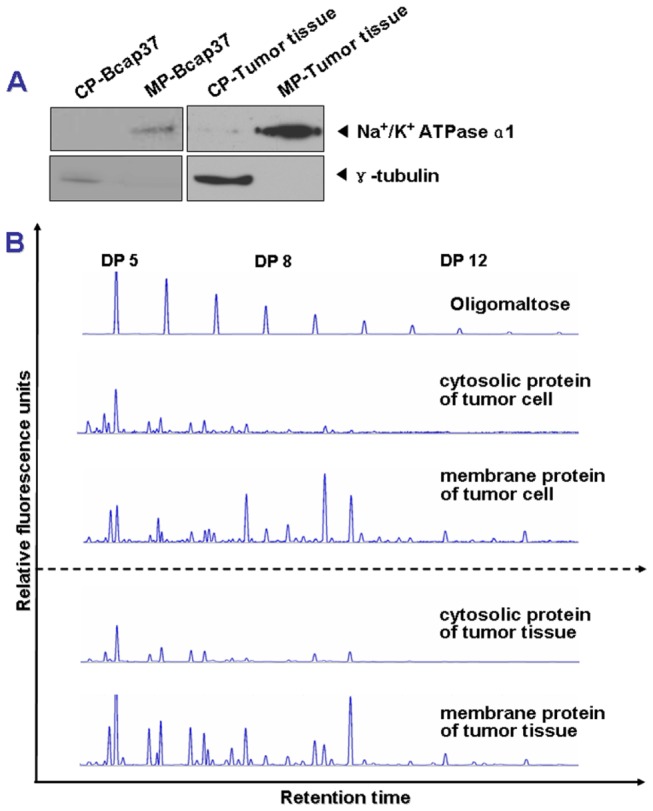
Establishment of the DSA-FACE method for analyzing N-glycan profiling in breast cancer.(A) Equal amounts (20 μg and 100 μg for cell line and tissue specimens, respectively) of cytoplasmic and membrane proteins (CP and MP) from Bcap 37 cells and tumor tissue were determined by Western blotting using γ-tubulin and Na+/K+ ATPase-α1 antibody, respectively. Na+/K+ ATPase-α1 (an integral membrane protein) and γ-tubulin (a core component of the centrosome) were chosen as the cytomembrane and cytoplasm markers, respectively. (B) The representative N-glycan profiles of cytosolic and membrane proteins from cell line (upper panel, n=8) and tissue (lower panel, n=200).